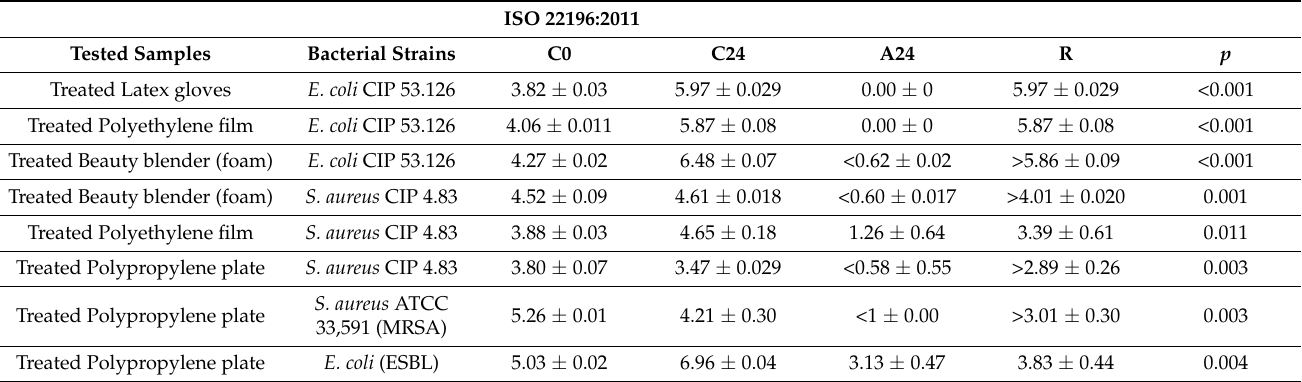
Table 3. Log CFU after 0 h (control C0) and 24 h of contact with different types of nonporous surfaces (control C24 and assay A24) and log reductions per cm 2